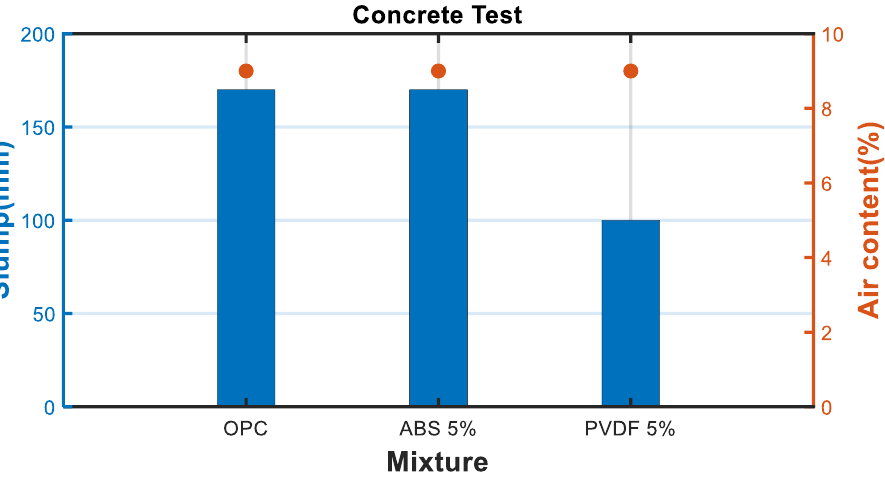
Figure 4. Slump and air content (Dot: air content; bar: slump).